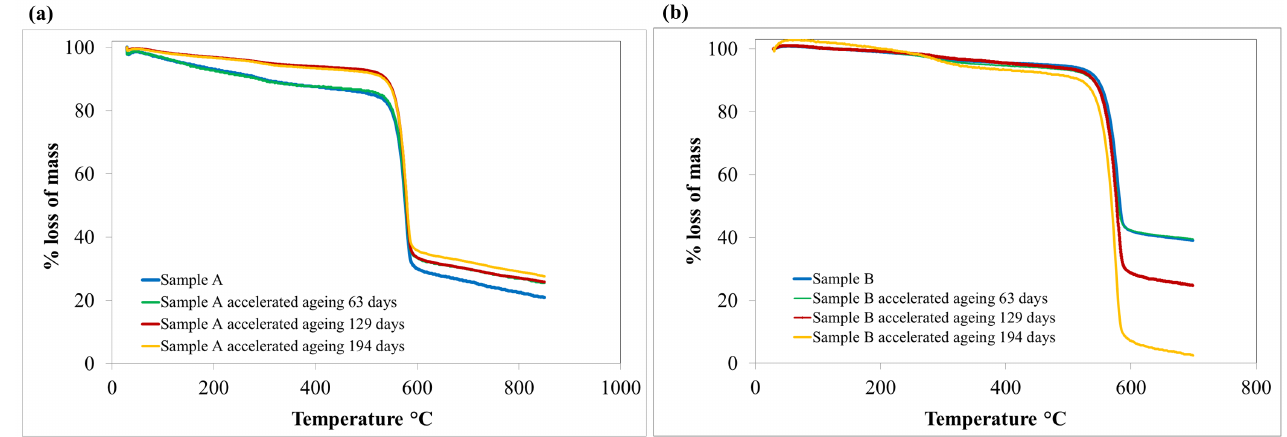
Figure 5. Thermogravimetric curves of sample A ( a ) and sample B ( b ). The results of the TG tests indicated a significant decrease in the temperature values for which there was a 5% mass loss of sample A and sample B of para-aramid materials as a result of accelerated aging processes, especially in those simulating the period of 4 and 6 years of ballistic insert use. In the case of sample A, after the accelerated aging process corresponding to the period of 6 years of use, the T5 temperature was reduced by 17% (from 355 °C to 294 °C), and for sample B, it was reduced by even 31%. The decrease in the temperature value at which there was a 5% loss in the mass of para-aramids may indicate changes taking place at the structural level after the aging processes. It is assumed that, in the case of sample B, the changes in the obtained value of the T5 parameter were related to structural changes of the PVB resin present in the pre-impregnate. Upon exposure to atmospheric air, this resin can slowly oxidize, leading to the formation of unsaturated carbonyl compounds, which are likely to have lower decomposition temperatures. The longer the aging process, the more resin is oxidized and the lower the T5 temperature values that can be obtained. On the other hand, sample A is a material with a WRT finish, which gives a hydrophobic character to the para-aramid fabric. The WRT finishing is a mixture of fluoropolymers such as fluoroacrylate polymers, antistatic agents (e.g., alkylphosphate compounds) and lubricants that reduce the resistance of machine elements used in production processes (e.g., a mixture of 1,3-dihydroxyalkyl-5,5-dialkylhydantoin, oleic acid ester and ethylene oxide) [31]. A decrease of the T5 value with increasing aging time may be related to the transfor- mation/degradation of compounds included in the WRT finish of the aramid fabric and/or oxidation of the surface of the para-aramid during the aging processes. [32] and practically did not change (temperature change below 2.5%) after the acceler- ated aging process compared to the reference sample. The T50 temperatures corre- sponding to the decomposition of the para-aramid assumed high values, which did not